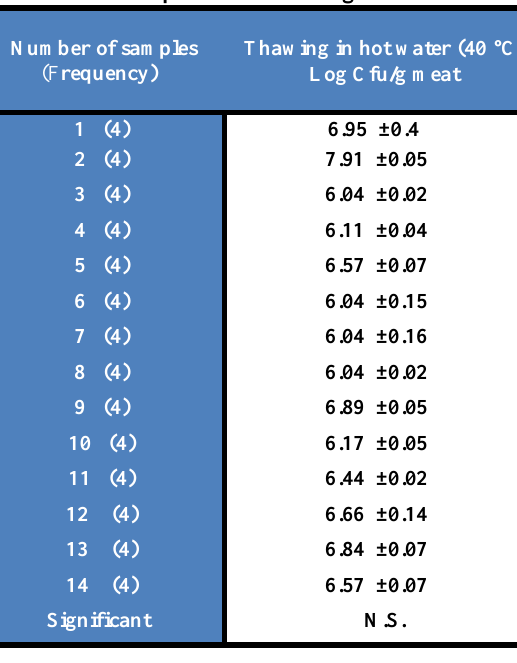
Table, 3: The mean values of total bacterial count in minced meat samples after thawing in hot